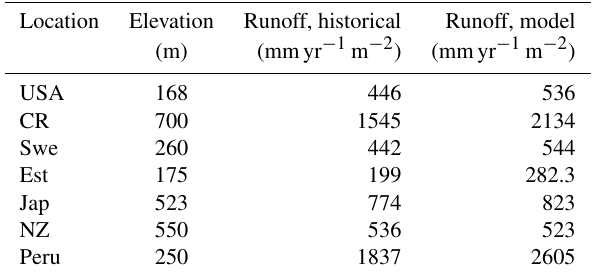
Table 2. Various characteristics of the sites where the model is run, including the local relief, and a comparison of the runoffs from the model and historical runoff data between 1958 and